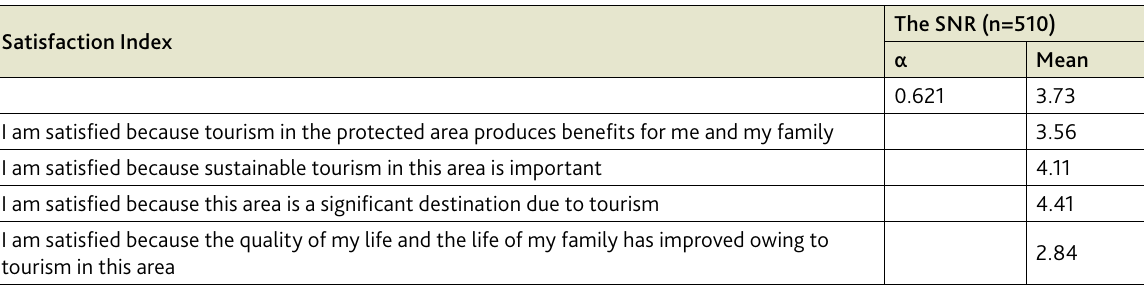
Table 3. Scale items for the satisfaction index